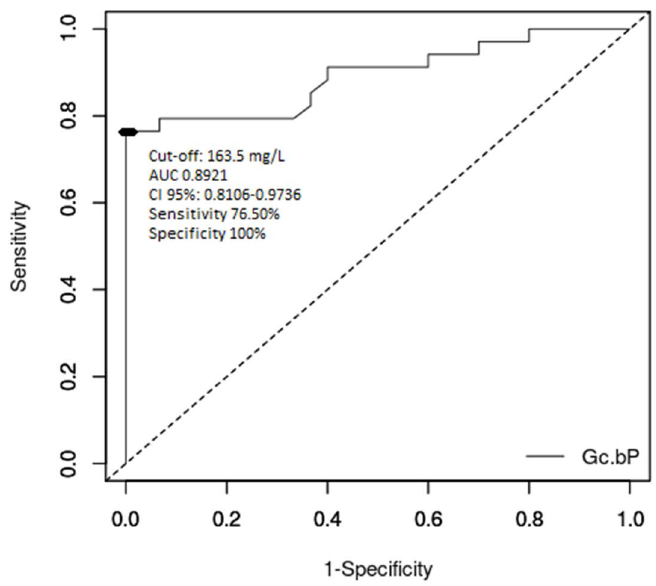
Figure 1. Receiver operating characteristics (ROC) curve for diagnosis of acute liver failure vs. healthy controls using serum levels of Gc-globulin.